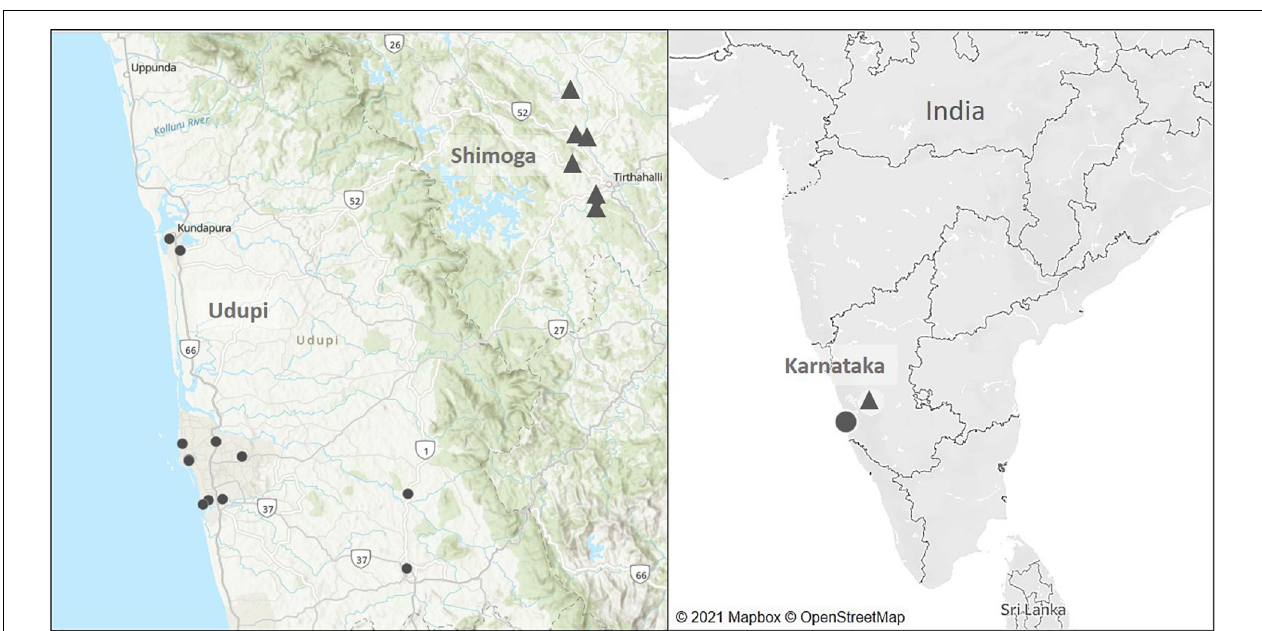
FIGURE 2 | Map of soil sampling locations in the main soil surveillance study from July 2016 to January 2019. Black dots mark the sampling sites located in Udupi (14 fields) and triangles represent sites in Shimoga (six fields).